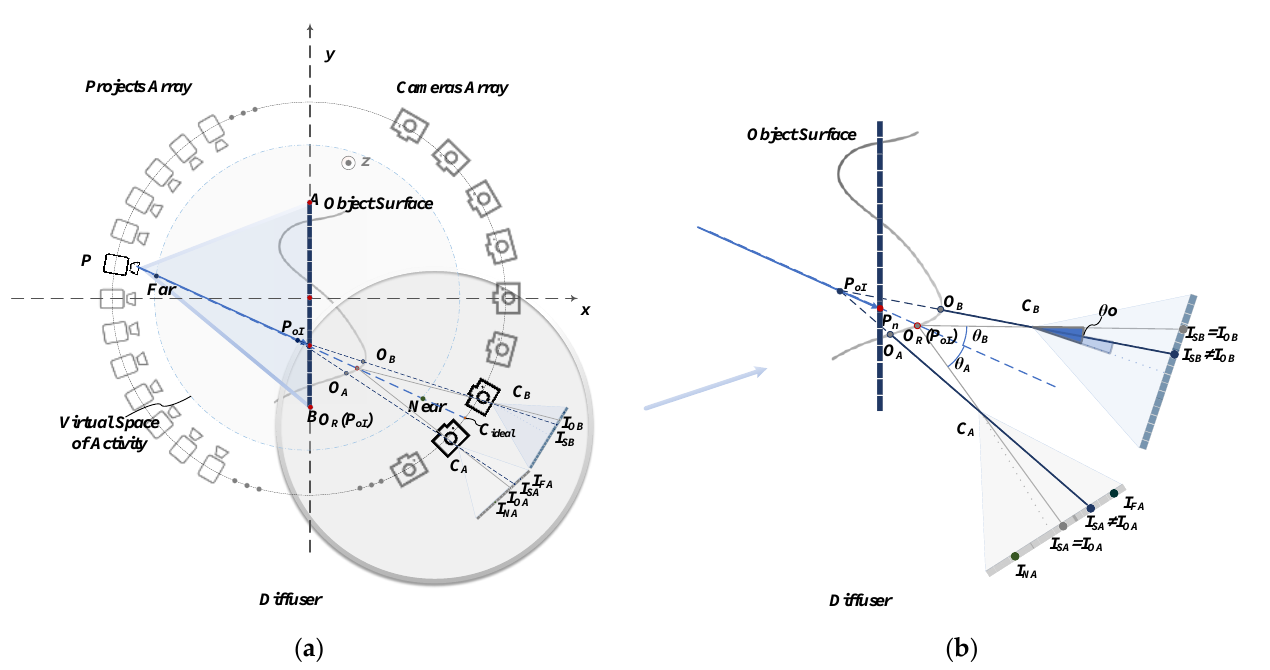
Figure 5. Schematic diagram of light-field coding algorithm based on target pixel matching ( a ) and local enlargement ( b ) .